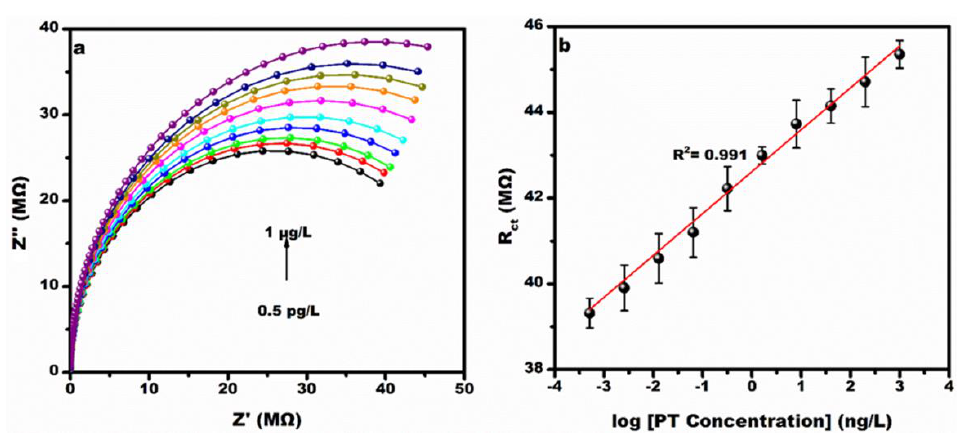
Figure 6. ( a ) Nyquist spectra and ( b ) calibration plot at different concentrations ranging from 0.5 pg/L to 1 µg/L parathion at anti-parathion/Au-IDE surfaces.